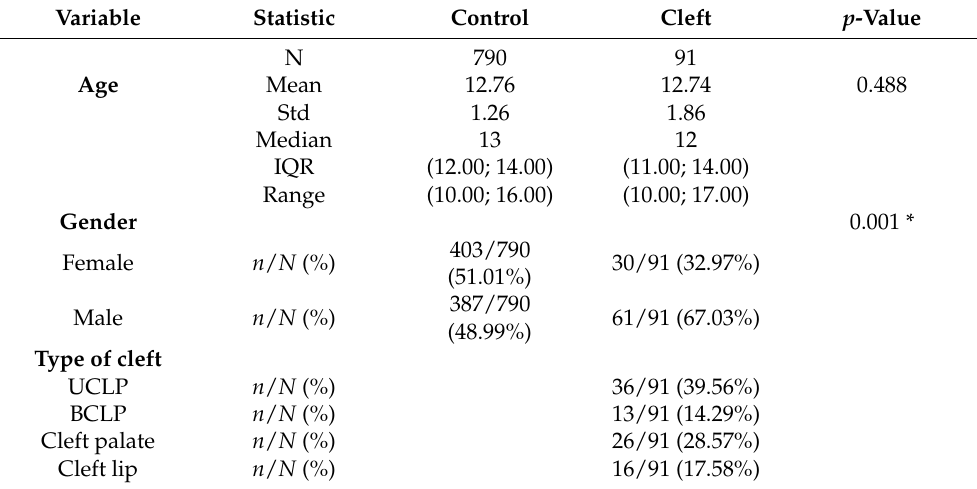
Table 1. Descriptive information of the sample.